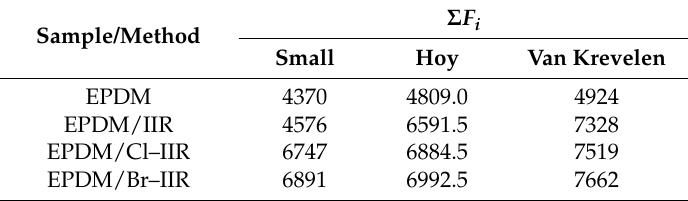
Table 3. Summary of molar attraction constants for EPDM rubbers.